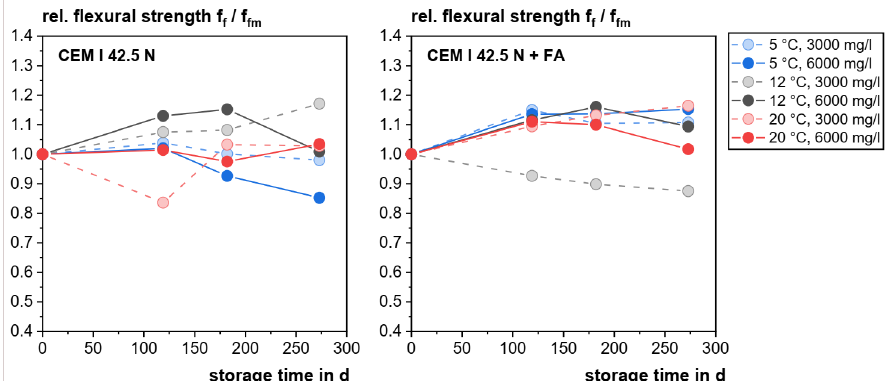
Figure 5. Relative flexural strength (ref.: maturity function) of concrete with CEM I 42.5 N and CEM I 42.5 N + FA (w/c eq = 0.50) after storage in Na 2 SO 4 solution. Table 7. Coefficient of variation R 2 and contribution of independent variables/interactions for regression models of the relative tensile strength (f t /f tm ) of concrete with w/c = 0.45 after 182 days storage in Na 2 SO 4 solution. Cement CEM I CEM I-SR3 CEM I + FA CEM II/B-S (1) R 2 54%